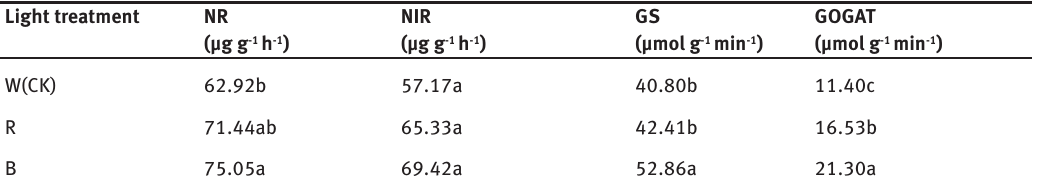
Table 4: Effects of 24 h continuous light on nitrogen metabolism enzyme activity in pakchoi. Light treatment